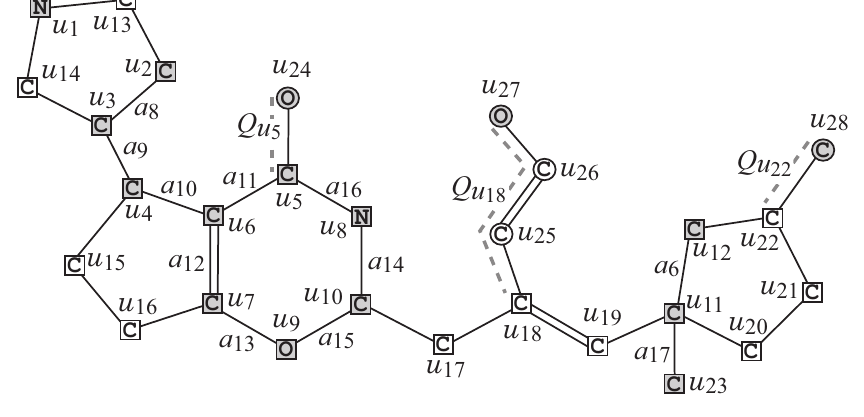
Figure 4. The interior H int of chemical graph G with ρ = 2 in Figure 2.